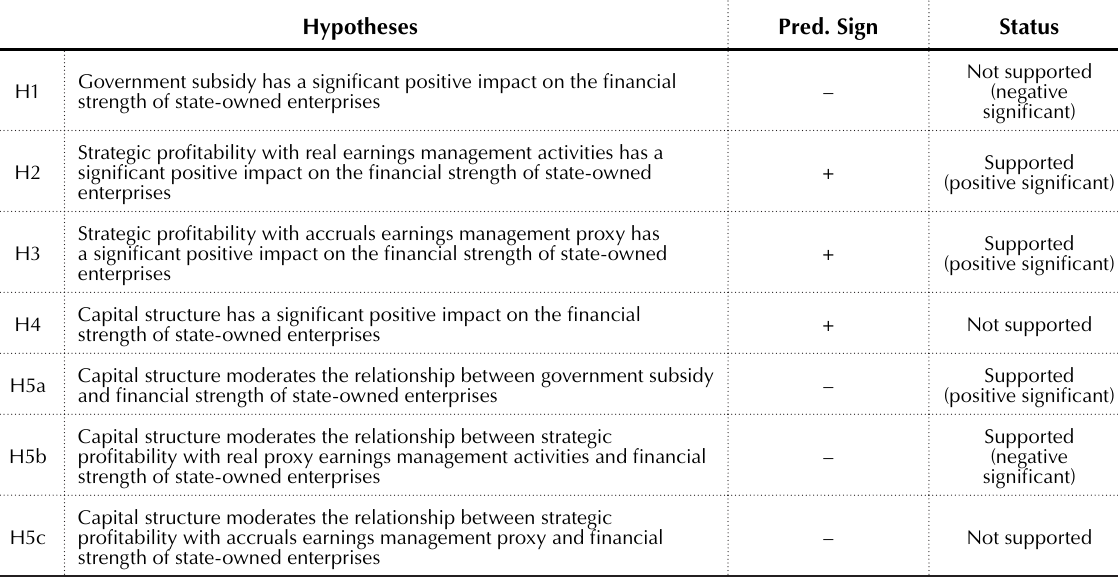
Table 5. Summary results of the hypotheses testing